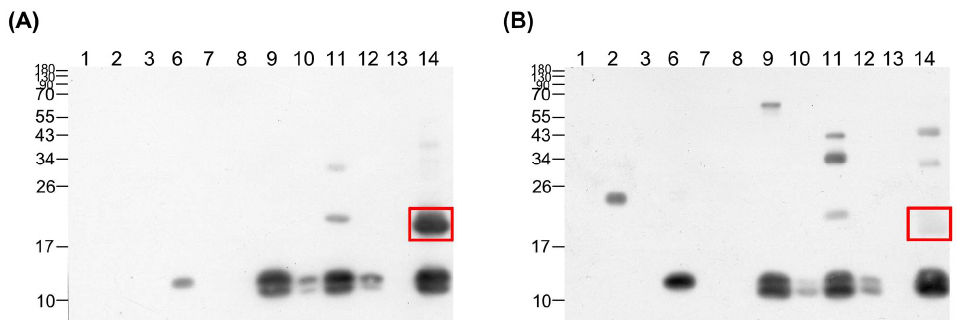
Figure 4. Western blot analysis of high-potency and low-potency horse plasma against HPLC- fractionated venom from hundred-pace pit vipers. HPLC-separated venom proteins were transferred to the PVDF membrane following SDS-PAGE and were probed with ( A ) high-potency and ( B ) low- potency plasma. The significant difference between the immunoprofiles of the two plasma samples is highlighted with a red